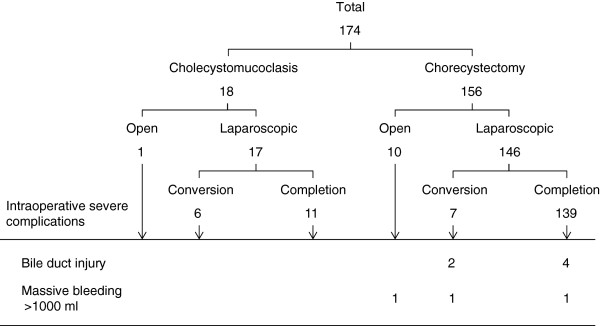
Detailed analysis of the severe intraoperative complications resulting from cholecystectomy.